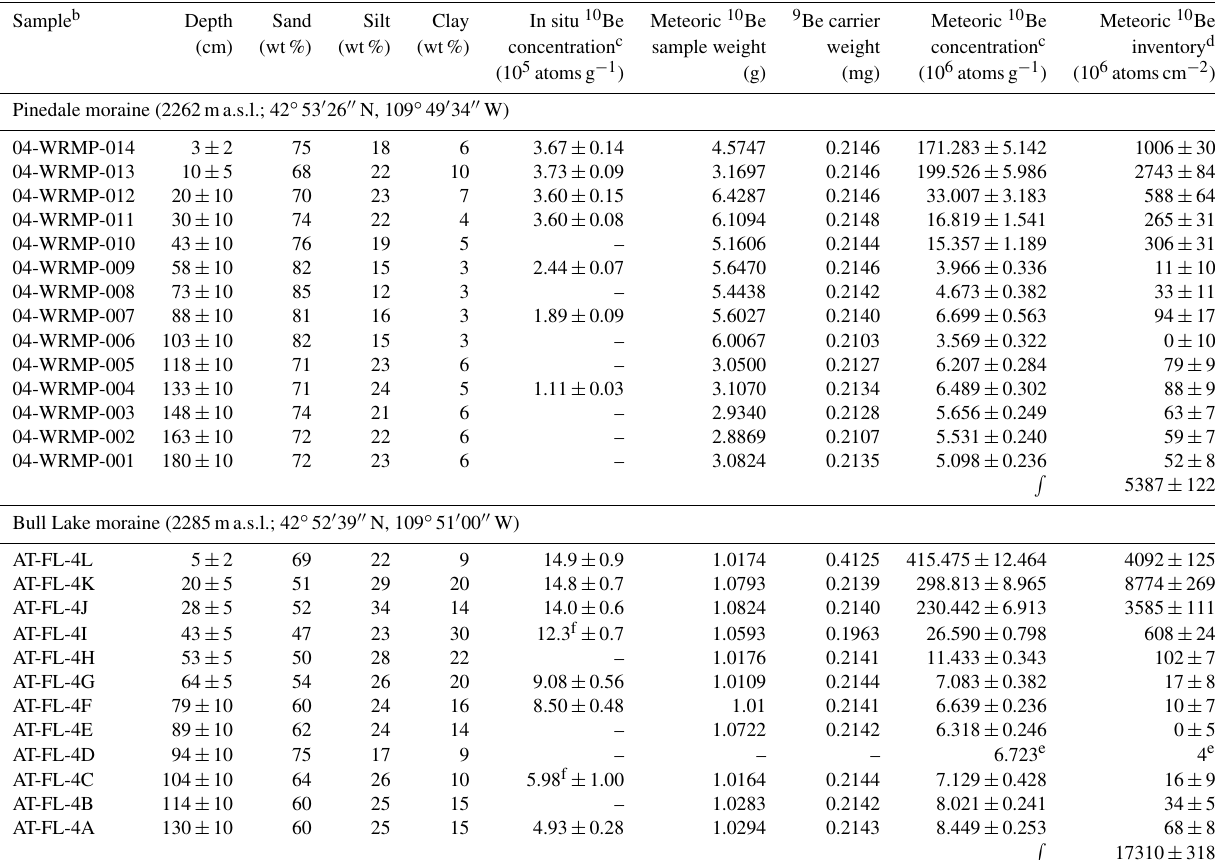
Table 2. 10 Be concentrations and GSD a in depth profiles from the Pinedale and Bull Lake moraines. Sample